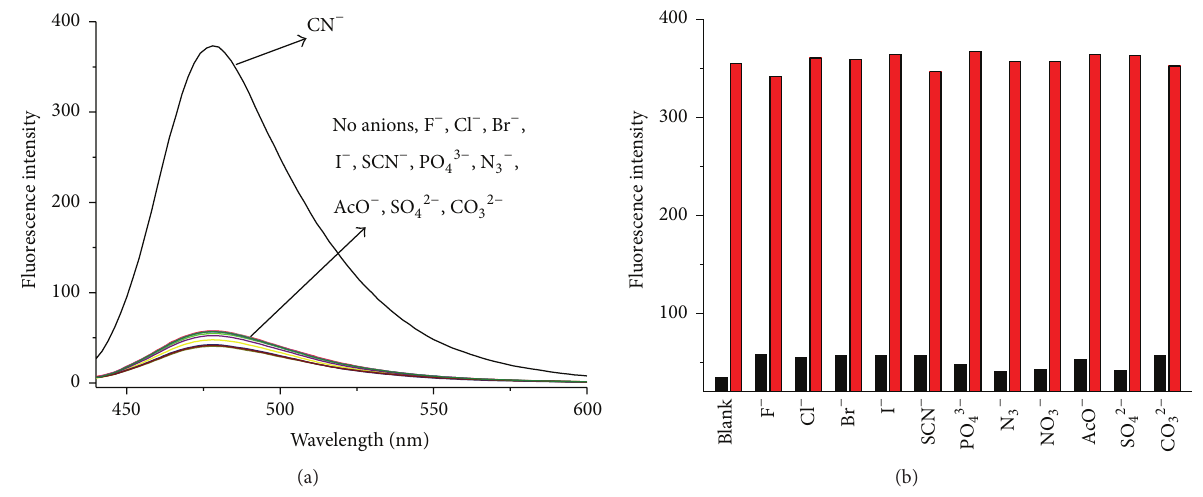
Figure 5: (a) Fluorescence changes of C -GGH-Cu 2+ (1.0 𝜇 mol/L) in the presence of various anions (15.0 𝜇 mol/L) in HEPES aqueous buffer (10mmol/L, pH 10.0). (b) Fluorescence responses of C -GGH (10 𝜇 mol/L) at 478 nm in the presence of different anions (15.0 𝜇 mol/L) (low bars), followed by addition of CN − (15.0 𝜇 mol/L) (high bars).